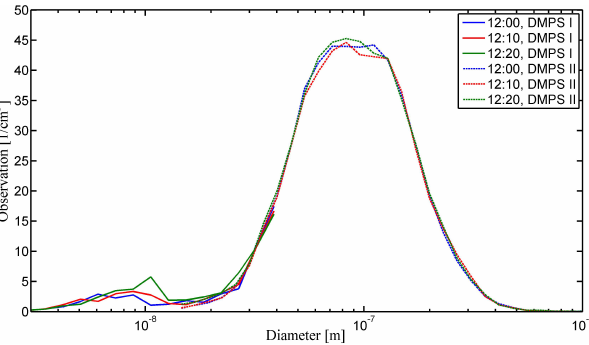
Fig. 5. Observations from 12:00 (blue), 12:10 (red), and 12:20LT (green) on 7 May 2010 from SMEAR II in Hyyti¨al¨a, Finland for DMPS I (solid) and DMPS II (dashed). Observed number concen- trations are on the y-axis [cm − 3 ] and particle diameter on the x-axis [m]. Note that the observations are presented in the characteristic